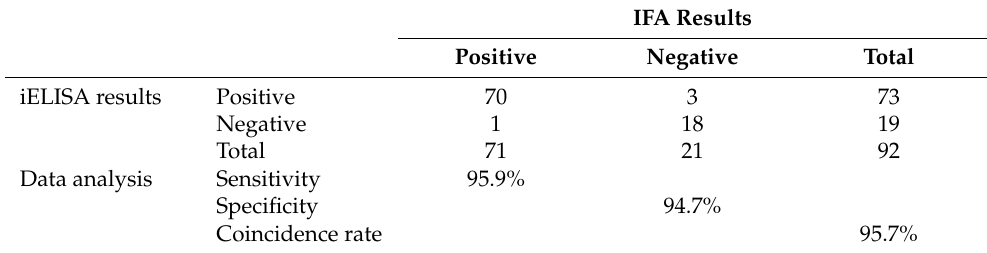
Table 3. Comparison of the iELISA with the IFA results.